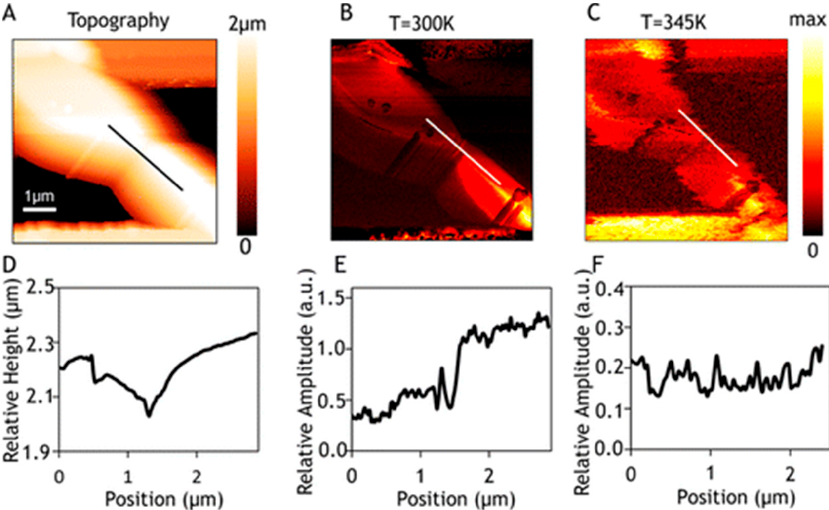
Figure 10. ( A ) Atomic force microscope image obtained via tapping mode on a suspended tapered VO 2 beam. ( B , C ) Near-field amplitude signal obtained at second harmonic demodulation on the same tapered VO 2 beam at 300K and 345K, respectively. ( D ) Relative height as a function of beam length at the line profile drawn across the tapered region in ( A ). ( E , F ) Relative amplitude as a function of beam length at the line profile drawn across the tapered region in ( B , C ). Reprinted with permission from ACS Publications.